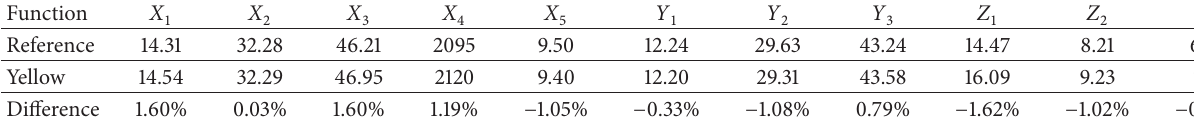
Table 10: Results obtained from the third model.